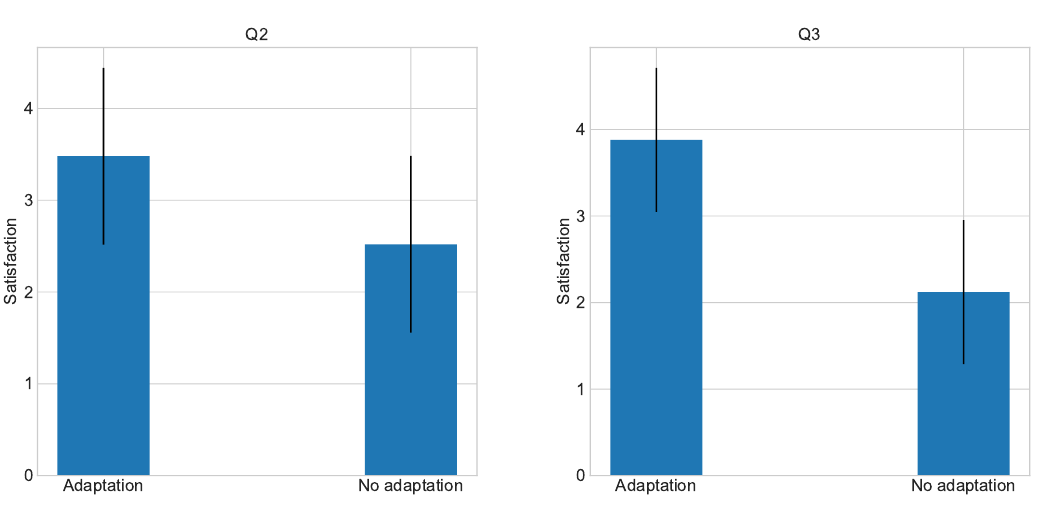
Figure 4. Results for Q2 and Q3.